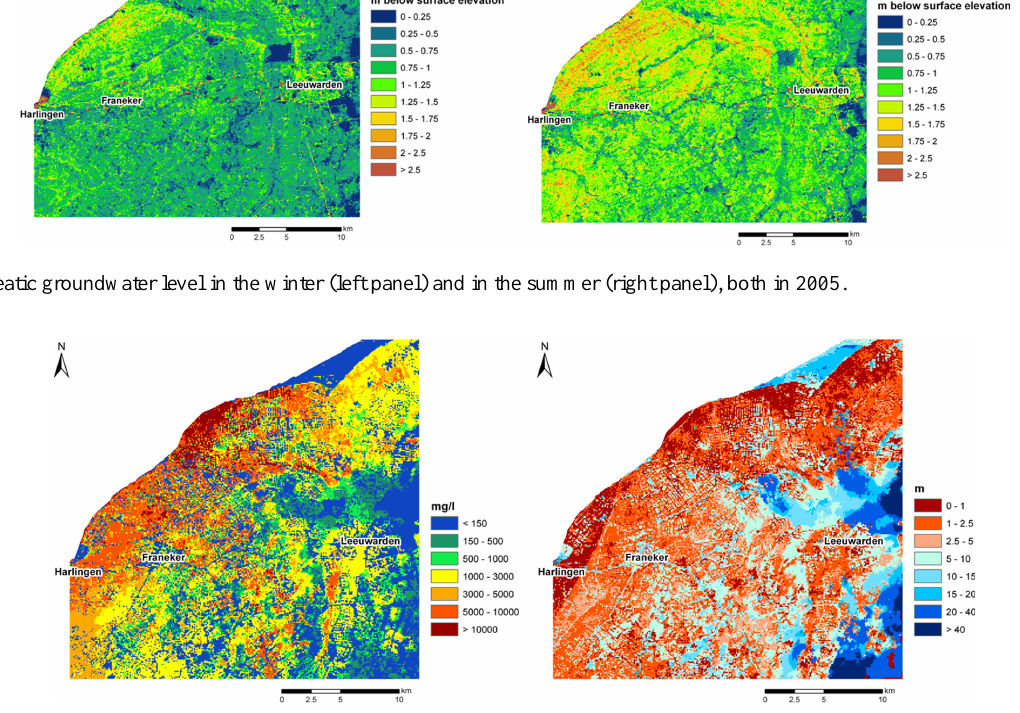
Fig. 16. Chloride concentration under the first confining layer in the winter and the summer of 2005 (left panel), and thickness calculated from the surface elevation of the fresh water lenses with Cl − < 1.5gl − 1 in the summer of 2005 (right